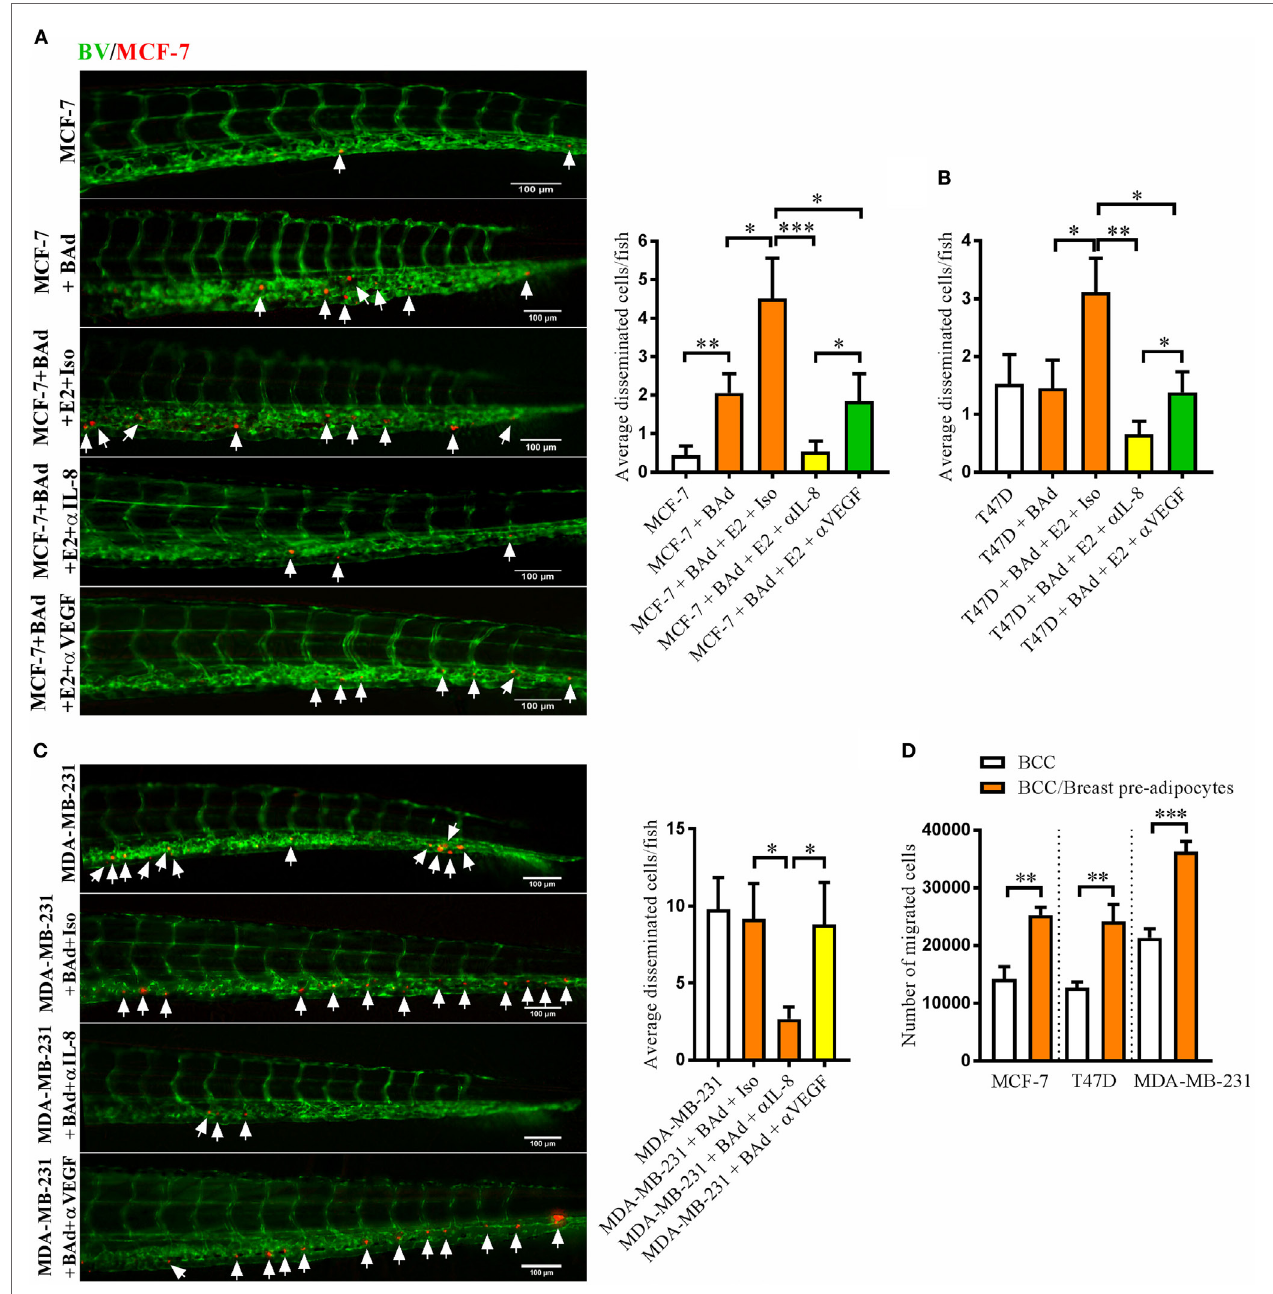
FigUre 3 | Anti-interleukin-8 (IL-8) treatment significantly decreased breast cancer cells (BCC) dissemination induced by breast adipocytes (BAd). Prior injections, breast pre-adipocytes were differentiated for 12 days and estrogen receptor positive (ER + ) BCC were cultured ± β -estradiol (E2) 1 nM for 48 h. All BCC were labeled with 4 µg/ml Fast DiI ™ oil red dye. Cells were injected ± anti-IL-8, anti-VEGF, or isotype control at 0.1 mg/ml ± E2 1 nM into the perivitelline space of 2 days old zebrafish embryos, which expressed enhanced green fluorescent protein in endothelial cells. (a) MCF-7 cells were injected alone or in combination with 50% BAd ± E2 1 nM. BCC dissemination was evaluated 3 days post-injections, n = 18–27 in each group. (B) T47D cells were injected alone or in combination with 50% BAd ± E2 1 nM. BCC dissemination was evaluated 3 days post-injections, n = 16–28 in each group. (c) MDA-MB-231 cells were injected alone or in combination with 50% BAd. BCC dissemination was evaluated 3 days post-injections, n = 14–18 in each group. (D) MCF-7, T47D, and MDA-MB-231 cells were cultured alone or in combination with 50% breast pre-adipocytes in vitro during 24 h, and migration of cells was determined as described in Section “Materials and Methods,” n = 6 in each group. BV = blood vessels. Arrows indicate disseminated BCC. Results are presented as mean ± SEM and analyzed by Student’s t -test, * p < 0.05, ** p < 0.01, *** p < 0.001. Data are representative of at least two independent